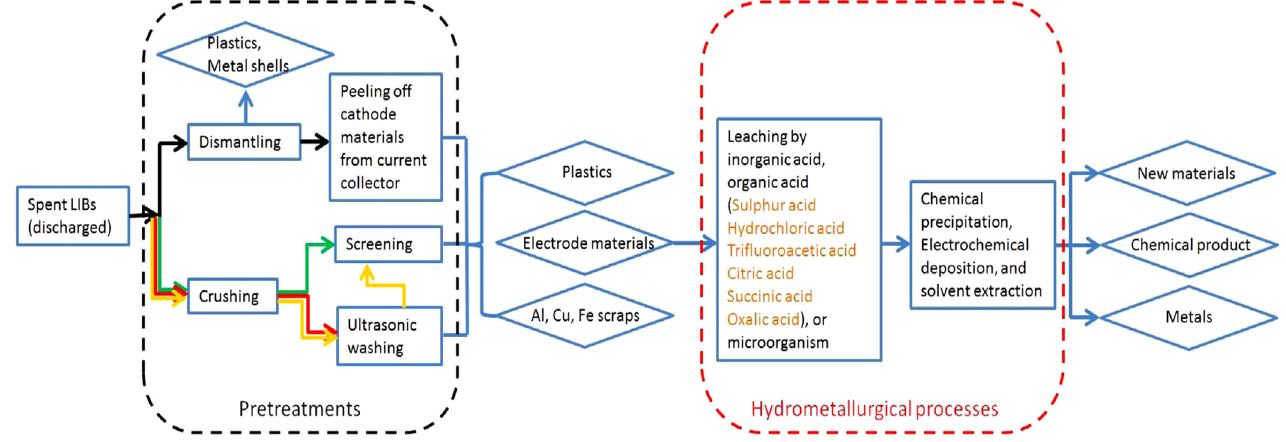
Figure 5. The typical flowchart of the recycling process of lithium-ion batteries (LIBs) [36].